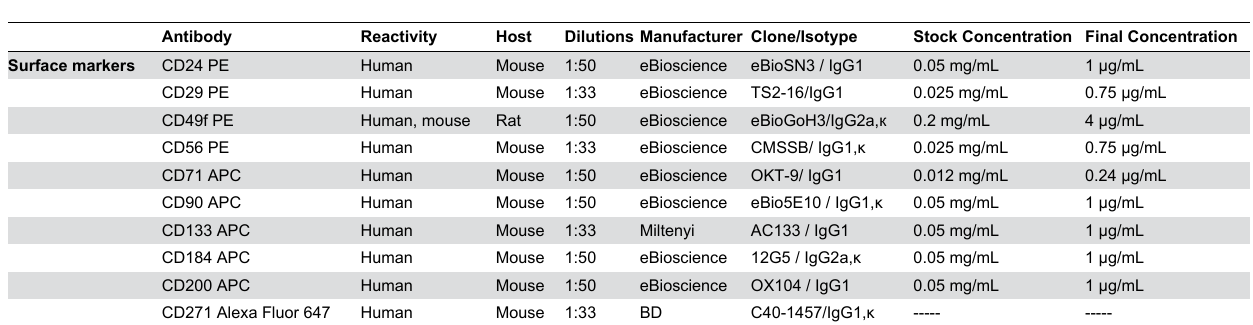
Table 2. Compilation of CD surface antigen antibodies used, including optimized dilutions and concentrations.